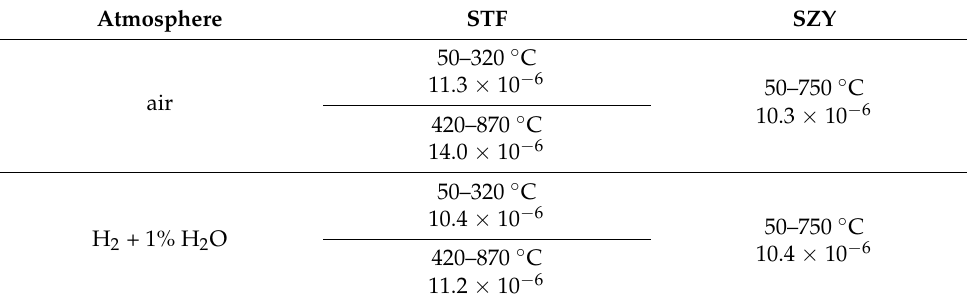
Figure 4. Relative linear expansion of SZY and STF vs. temperature in air and hydrogen atmosphere (H 2 + 1% H 2 O). Table 1. TECs of STF and SZY .